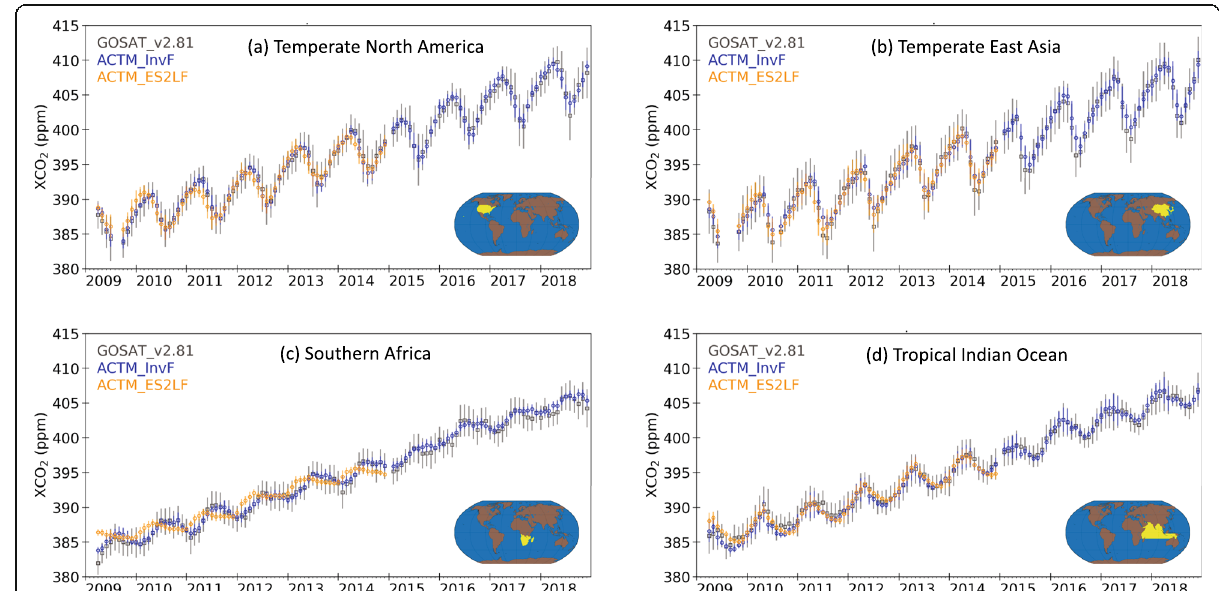
Fig. 6 Time series XCO 2 for 4 selected parts of the world. Values are aggregated over the regions highlighted by yellow. The detailed results for 15 land and 11 ocean regions are shown for the time series, ACTM_InvF/ACTM_ES2L-GOSAT, and their detrended seasonal cycles (GIF Animation S1). Comparisons with OCO-2 data are also shown in supporting materials (GIF Animation